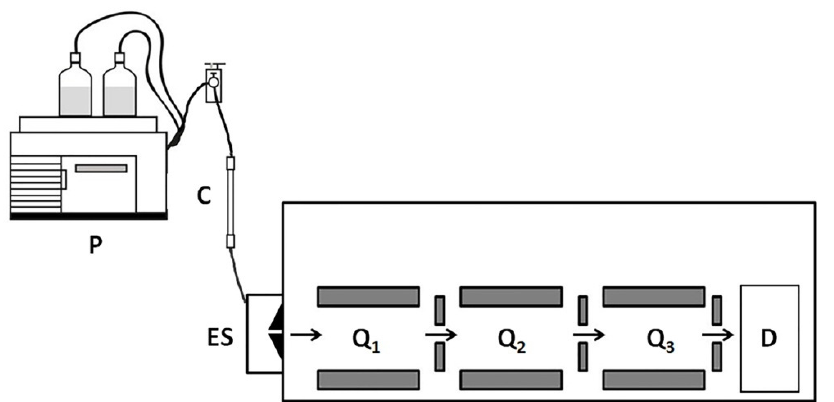
Figure 2. Liquid chromatography coupled to tandem mass spectrometry (LC-MS/MS). The experi- ment begins with a protein separation by liquid chromatography (LC) followed by ionization and mass spectrometry analysis. Triple quadrupole mass spectrometer comprises of three quadrupoles Q 1 , Q 2 , and Q 3 . Quadrupoles Q 1 and Q 3 serve as mass filters. The middle quadrupole Q 2 functions as a collision cell. The specific precursor ions isolated by Q 1 and accumulated in Q 2 collide with neutral gas molecules, such as nitrogen generating the product ions. The product ions reach the third quadrupole assembly Q 3 . The quadrupole Q 1 allows ions with a specific m/z ratio range to pass to the detector (D). P—pump; C –column; ES—electrospray, a liquid-to-aerosol converting de- vice.